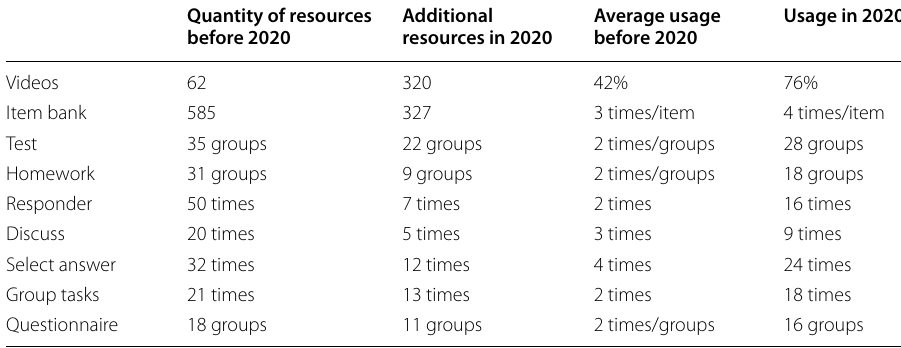
Table 1 Application statistics of analog circuit online